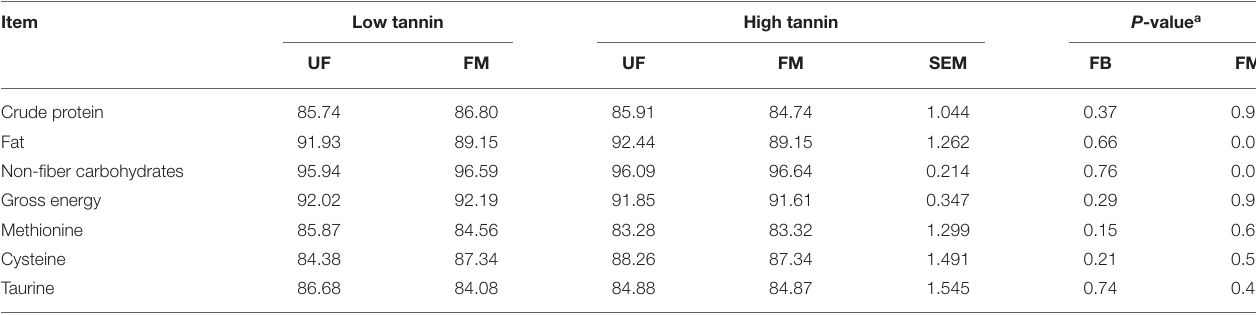
TABLE 6 | Apparent total tract digestibility of dogs fed diets formulated with either low or high tannin fava beans without (UF) or with (FM) fermentation for 7 days each * .